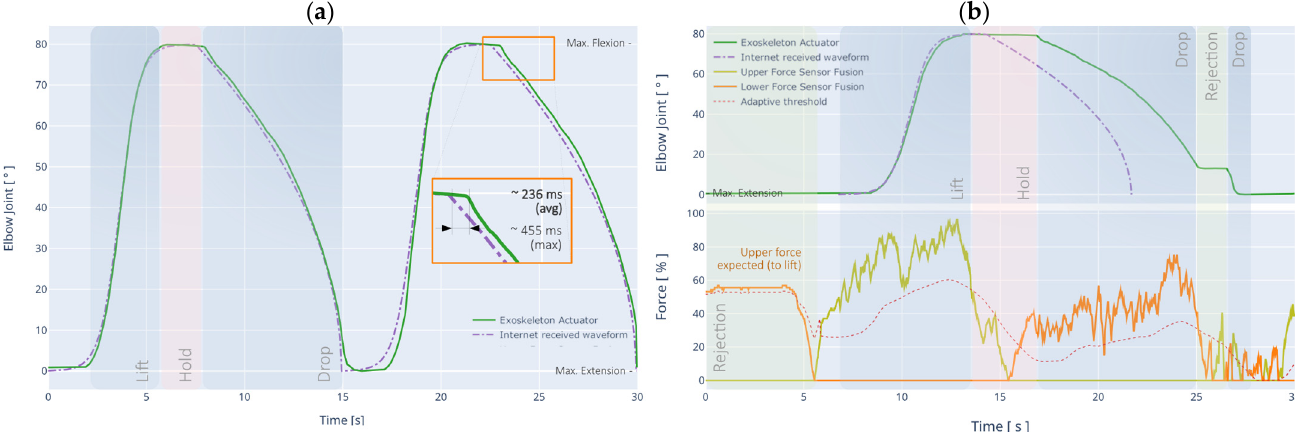
Figure 12. Remote Mode Controller (RMC) test using a custom trajectory sent through the Internet. Part ( a ) shows the exoskeleton response to the trajectory. Part ( b ) shows the time compensator action in the same procedure.